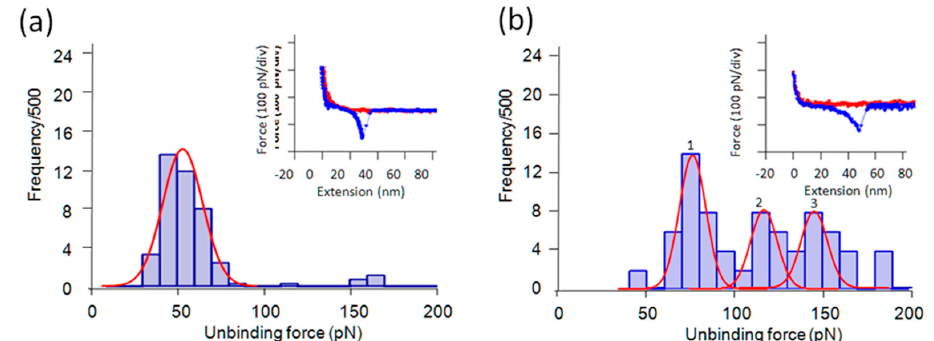
Figure 4. Force curves and histograms of two oligo-Glys ( a ) Tri-Gly ( b ) Penta-Gly. Three peaks were identified in the penta-Gly histogram with the mean of 70 pN (peak 1), 110 pN (2), and 140 pN (3). The higher force peaks were considered to correspond to cooperative unbinding of two or more binding units.